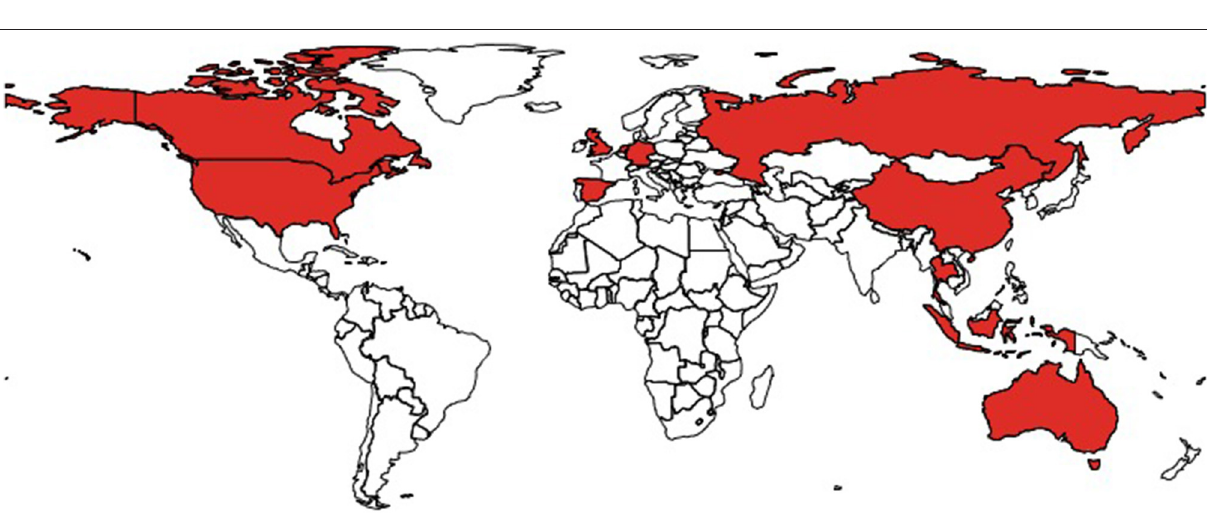
FIGURE 3 | Map highlighting the advertised countries of origin of sellers offering bat items on eBay Australia, Canada, Italy, Switzerland, UK, USA between 11th and 25th of May